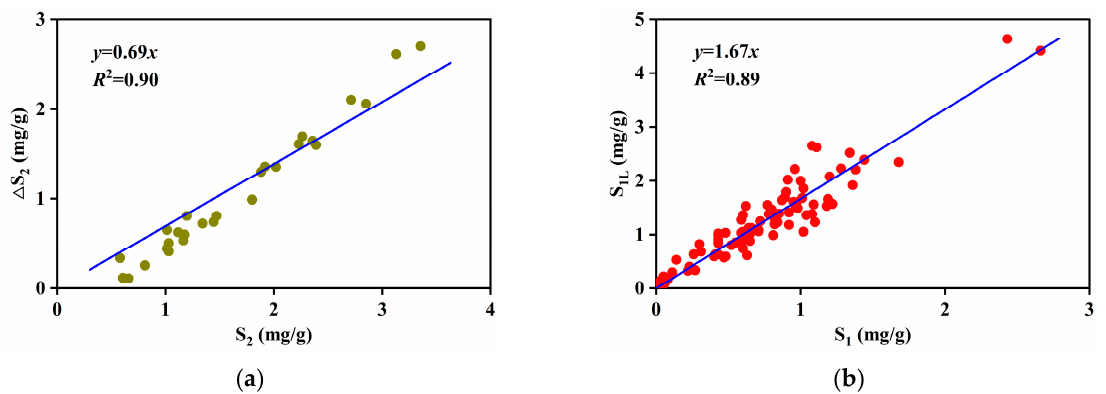
Figure 5. Heavy ( a ) and light ( b ) hydrocarbon correction models.